Question: Briefly state, in one sentence, what is plotted here.
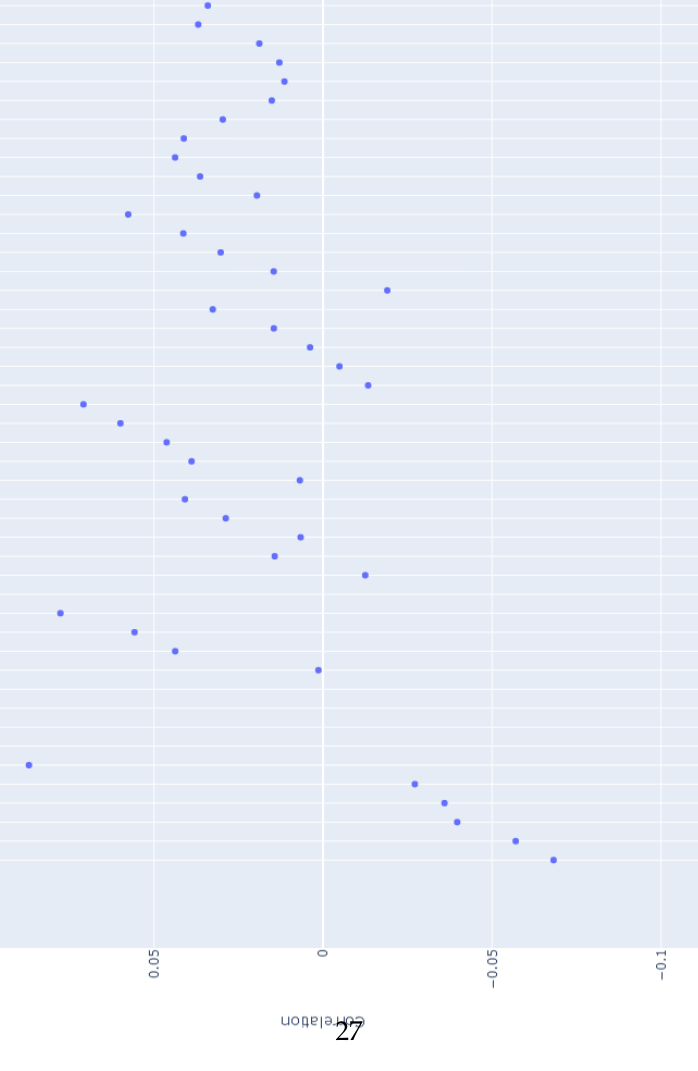
Answer: Feature correlations with reduction for English